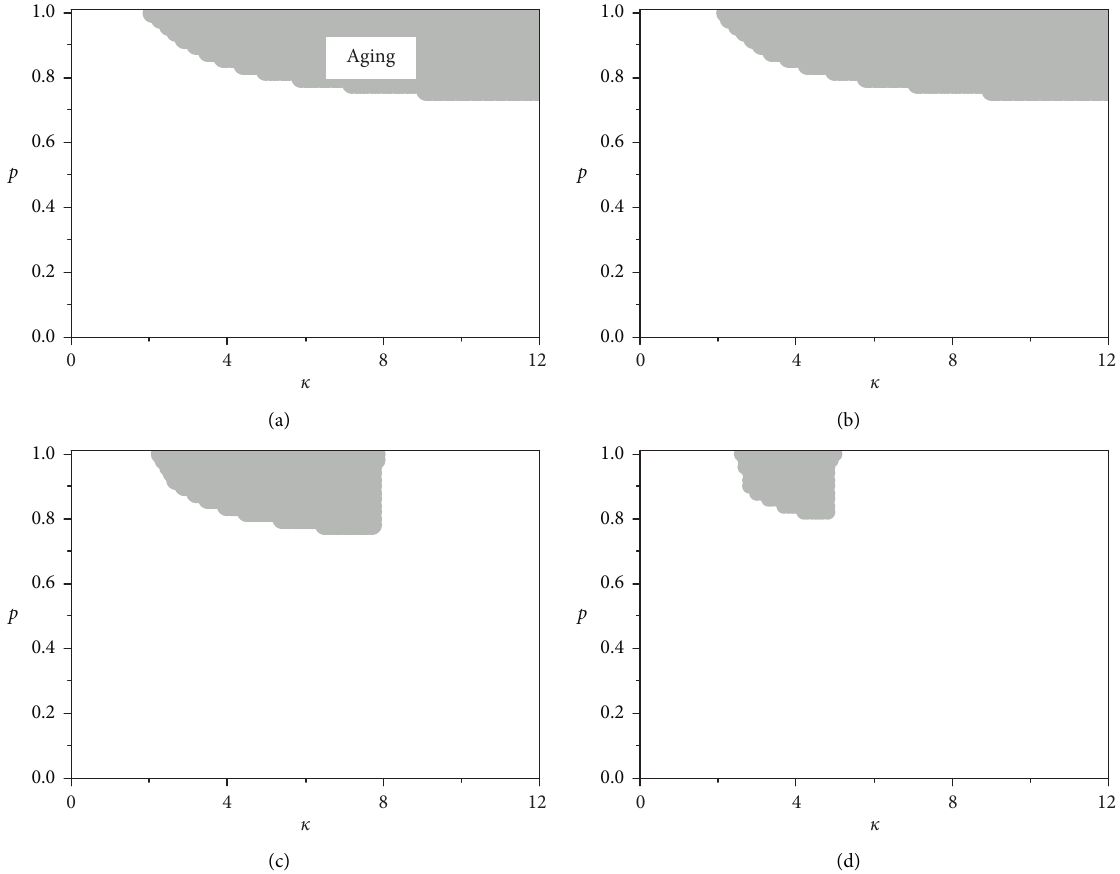
Figure 6: (a)–(d) Phase diagrams on the ( κ , δ ) plane for aging transition and oscillatory regions with δ � 0 . 0, 0.05, 0.12, and 0.15, re- spectively. The word “aging” represents the aging transition region, and the white region is the oscillatory